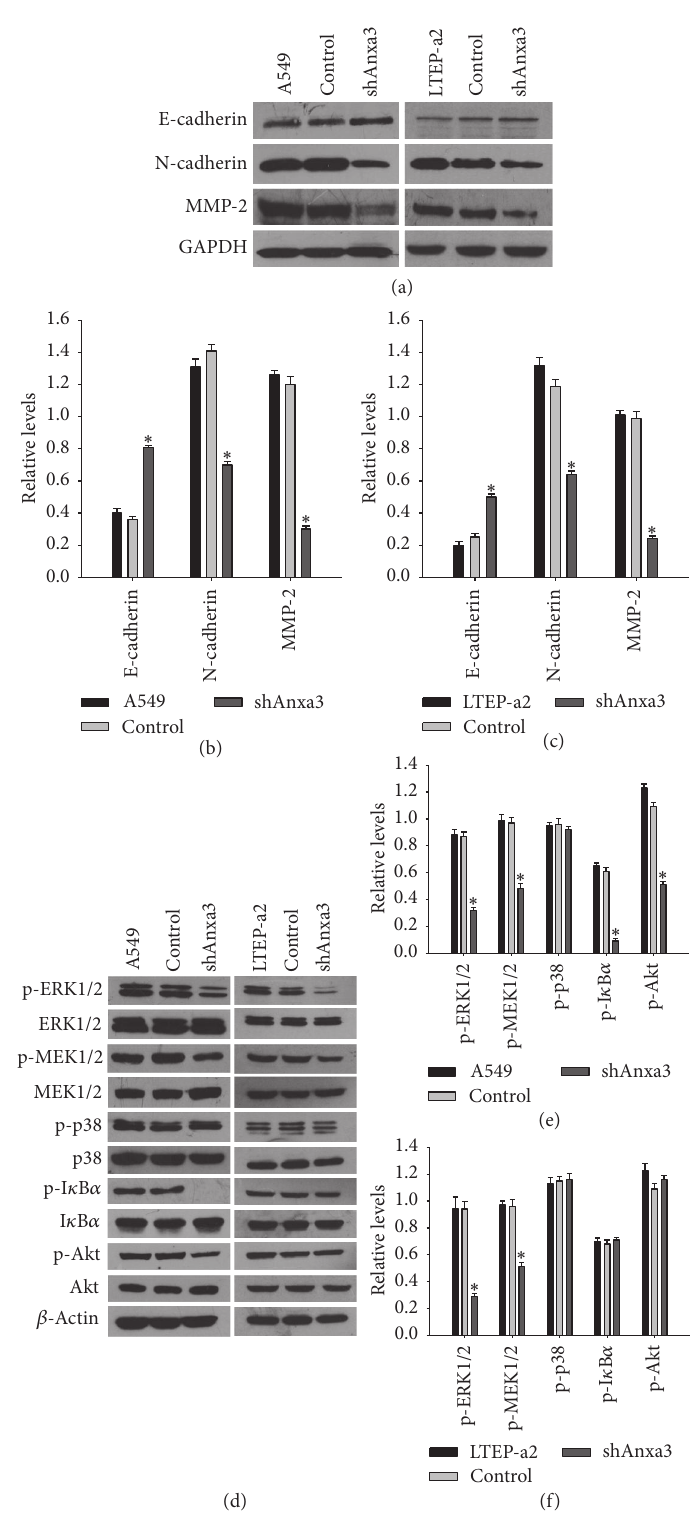
Figure 3: Knockdown of Anxa3 expression affected the expression of some effector molecules and some signaling molecules. (a) Western blot analysis of the expression of MMP-2, N-cadherin, and E-cadherin. (b, c) Histograms of the relative expressions of the effector molecules. ∗ indicates 𝑝 < 0.05 . (d) Western blot analysis of the expression of some cancer-associated signaling molecules in A549 and LTEP-a2 cells and their corresponding stably transfected cell lines. (e, f) Histograms of the relative expressions of the signaling molecules. ∗ indicates 𝑝 < 0.05